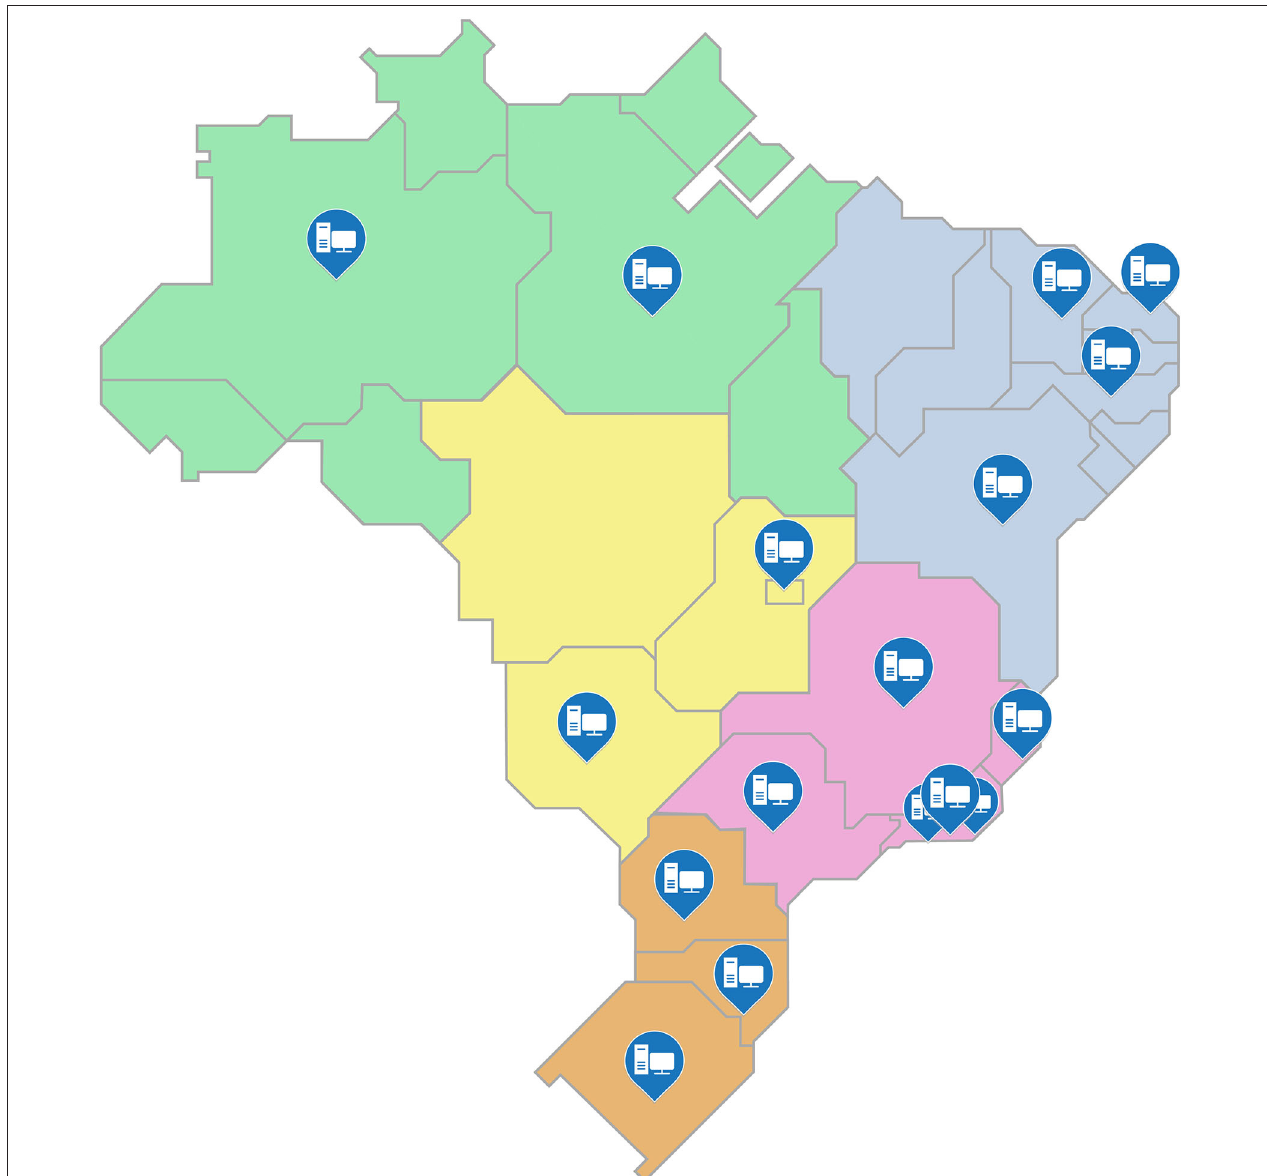
FIGURE 2 | Distribution of sentinel laboratories contemplated in the scope of the “Syphilis No!”